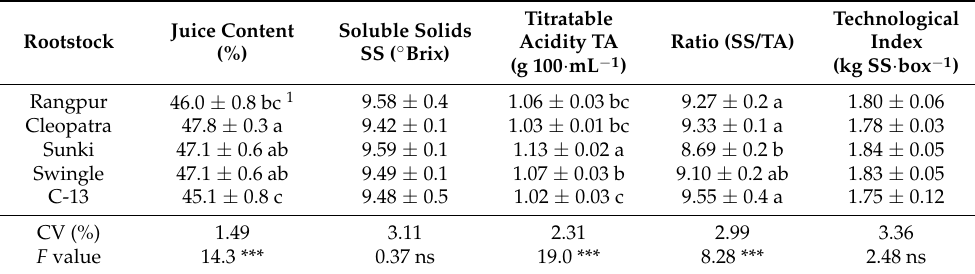
Table 4. Nine-season average juice quality of ‘Shamouti’ sweet orange fruit from trees grafted on different rootstocks grown in Londrina, state of Paran á , Brazil, from 2009 to